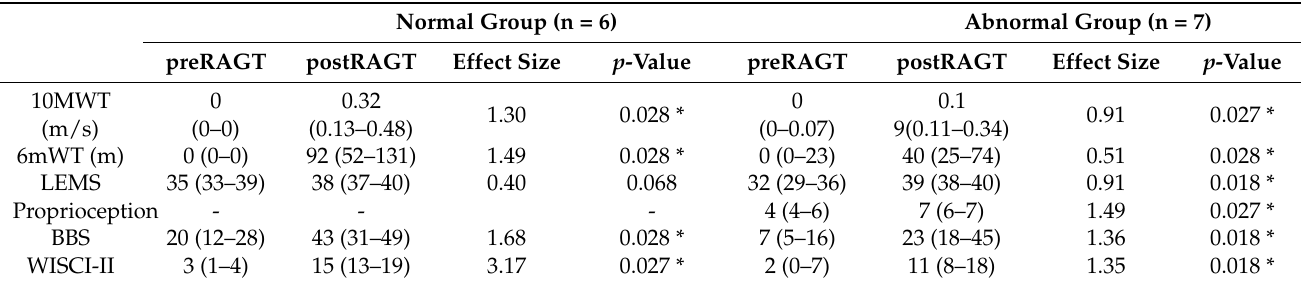
Table 3. Clinical outcome measures at baseline and after intervention by initial proprioception